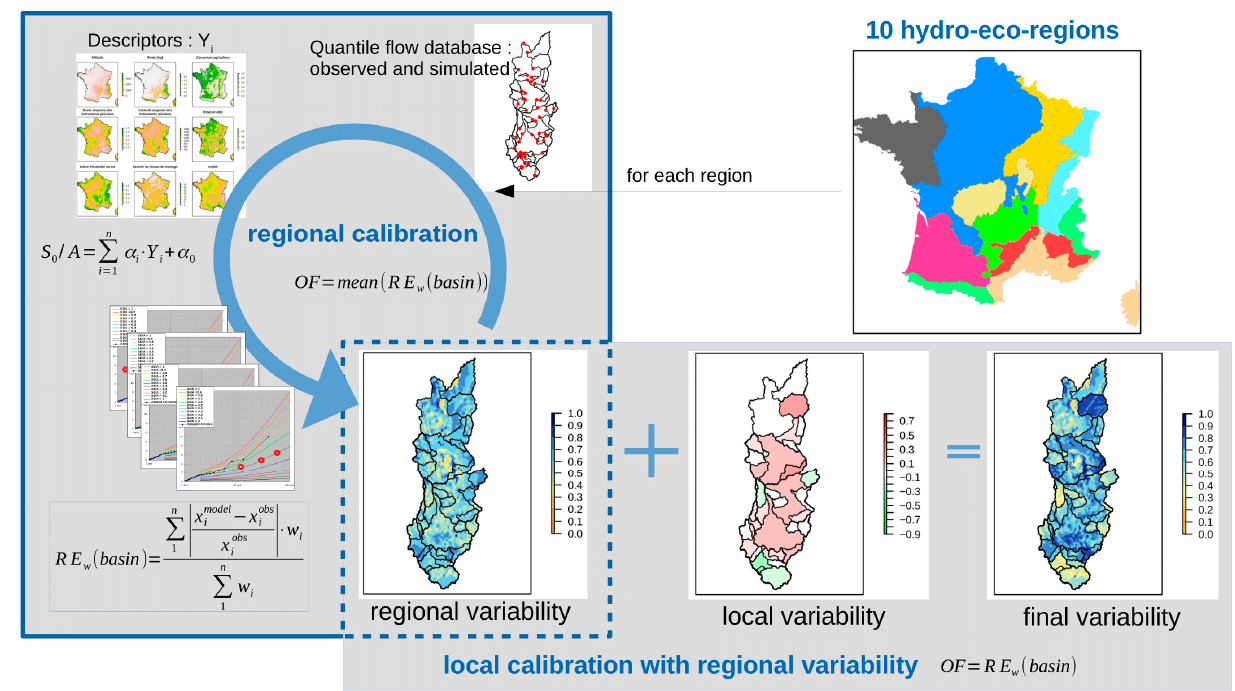
Figure 2. Regional calibration process.